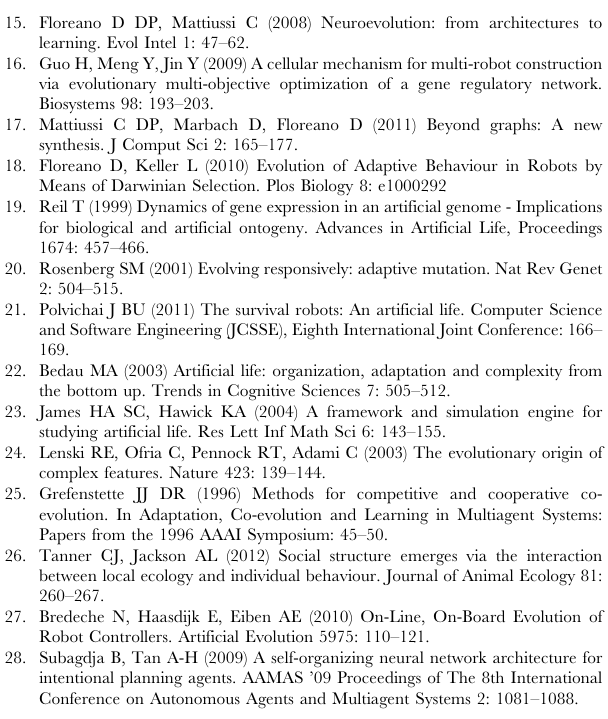
Table S1 Table S1 lists the different parameters used in the artificial life robot simulations. Table S2 Table S2 lists the different types of food sources used in the